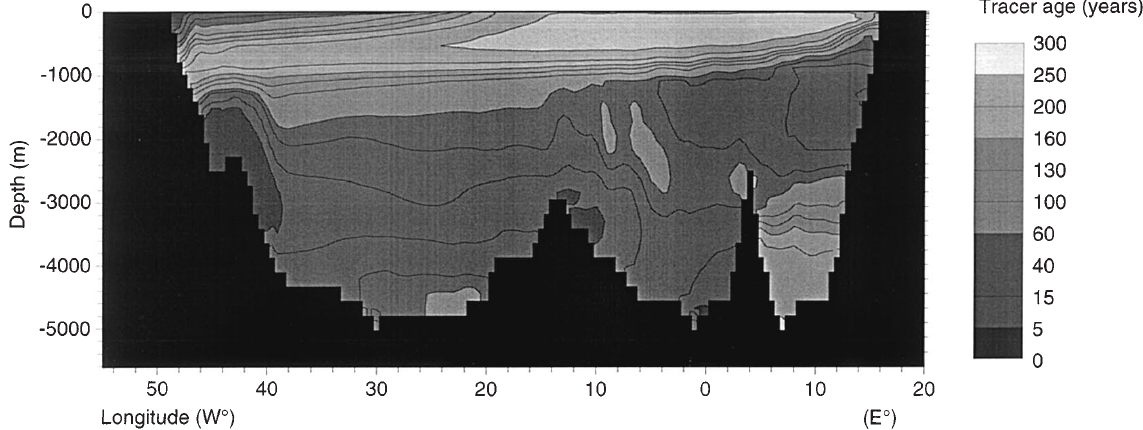
Fig. 1. A zonal section at 27 (cid:14) S from South America (50 (cid:14) W) to South Africa (18 (cid:14) E), illustrating the age of tracer introduced at the Atlantic Ocean boundary (24